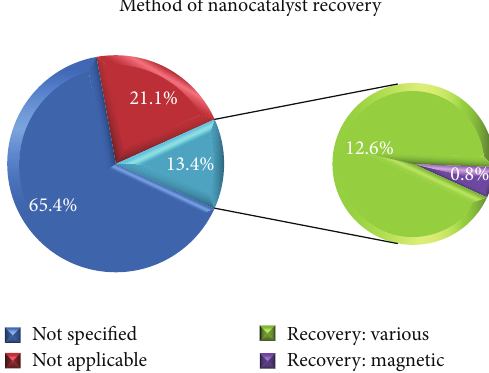
Figure 11: Recovery methods considered in patents related to nanocatalysis (based on a research on the US Patent and Trademark Office Patent Database (http://patft.uspto.gov/) applying the work- ing definition stated in the beginning of this review).